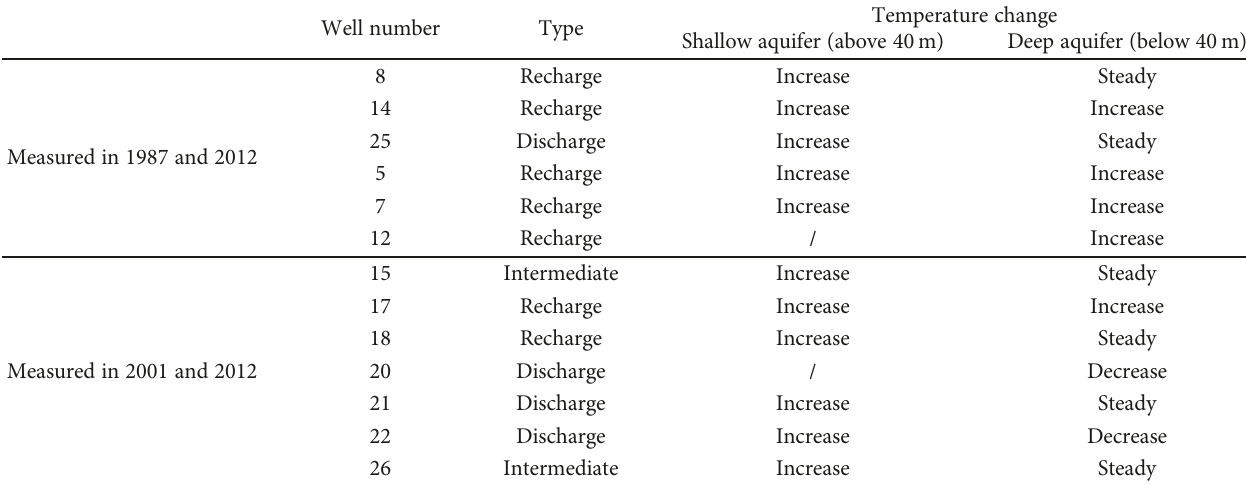
Figure 6: Distribution of the observation wells in the Kumamoto Plain with recharge, intermediate, and discharge types of thermal pro fi les. Table 3: Changes in twice-repeated temperature